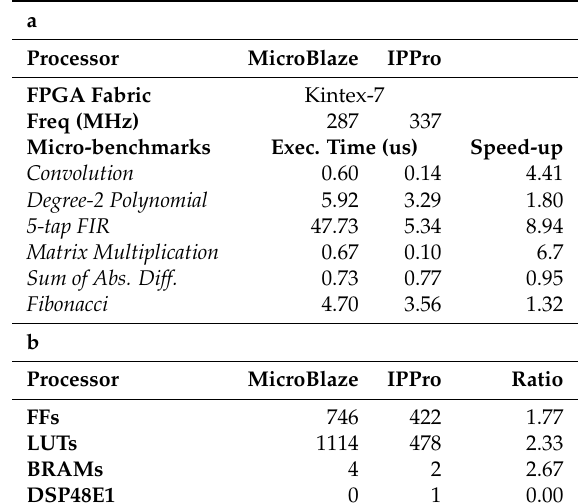
Table 5. Performance comparison of IPPro and MicroBlaze implementations ( a ) Comparison of micro-benchmarks. ( b ) Area